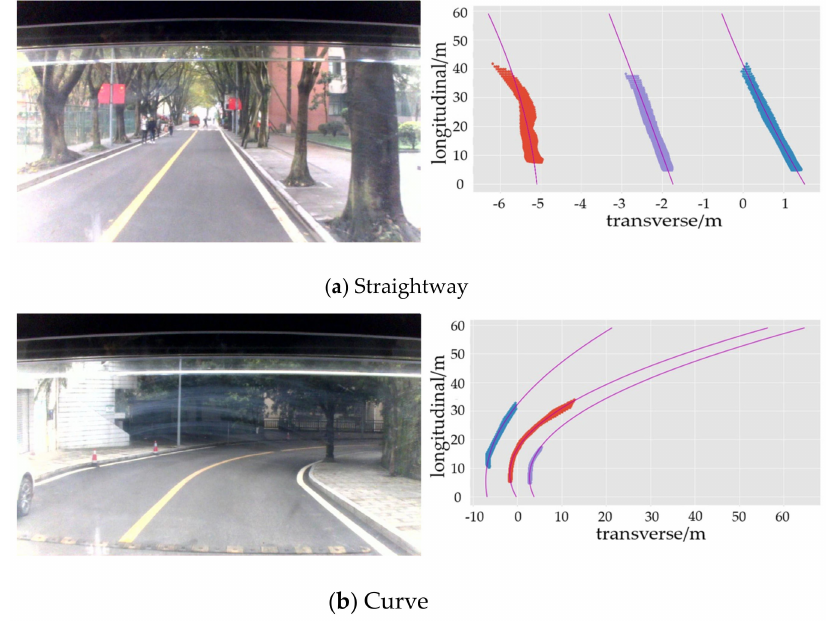
Figure 16. Effect of